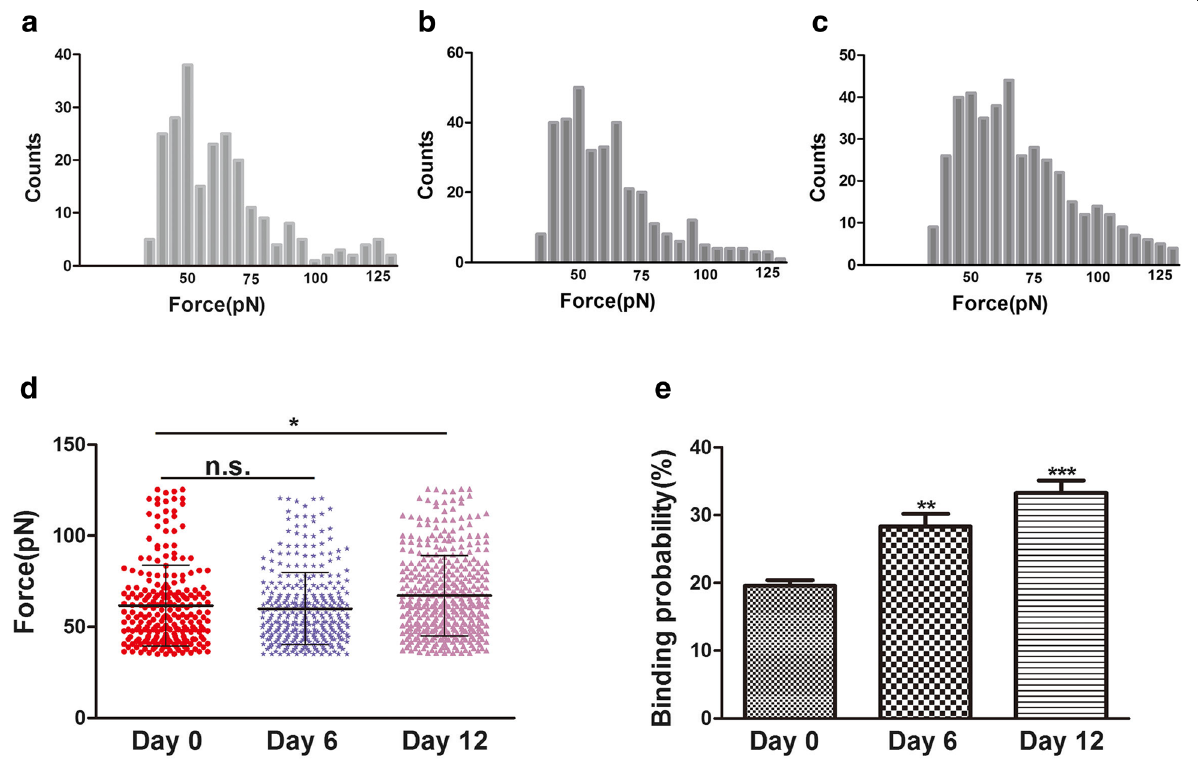
Fig. 5 Binding force and binding probability measured on the surface of living hADSc by integrin β 1-functionalized AFM tips. a – c Histograms of the binding force of integrin β 1 antibody – receptor obtained during hADSc chondrogenic differentiation for 0, 6 and 12 days. d Binding forces for integrin β 1 – receptors were obtained on 0, 6, and 12 days of chondrogenic differentiation of hADSc. e Binding probability of integrin β 1 – receptor was detected during chondrogenic differentiation of hADSc for 0, 6, and 12 days. * p < 0.05, ** p < 0.01, *** p < 0.001, n.s. no significant